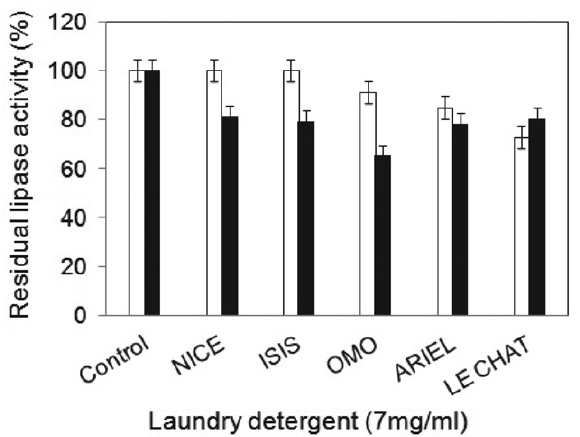
Figure 8 . Residual activities of AKL29 ( □ ) and CRL (■) in the pres- ence of various commercial laundry detergents: enzymes were incu- bated for 60 min at 40 °C in the presence of detergents at a final concentration of 7 mg/mL. The residual activities were determined at pH 8 and 45 °C using olive oil emulsion as a substrate. Enzymes activities determined without any detergent and incubated under the similar conditions, were taken as 100% (control). The experi- ments were conducted three times and standard errors are reported. Vertical bars indicate standard error of the